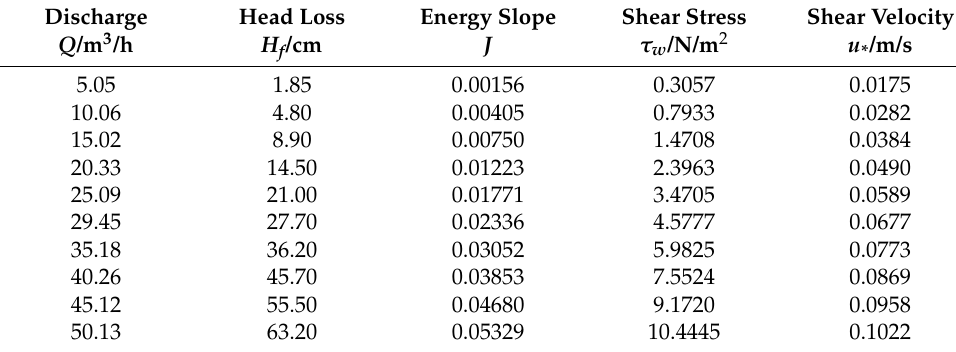
Table 2. Shear velocity for different flow rates under clear water